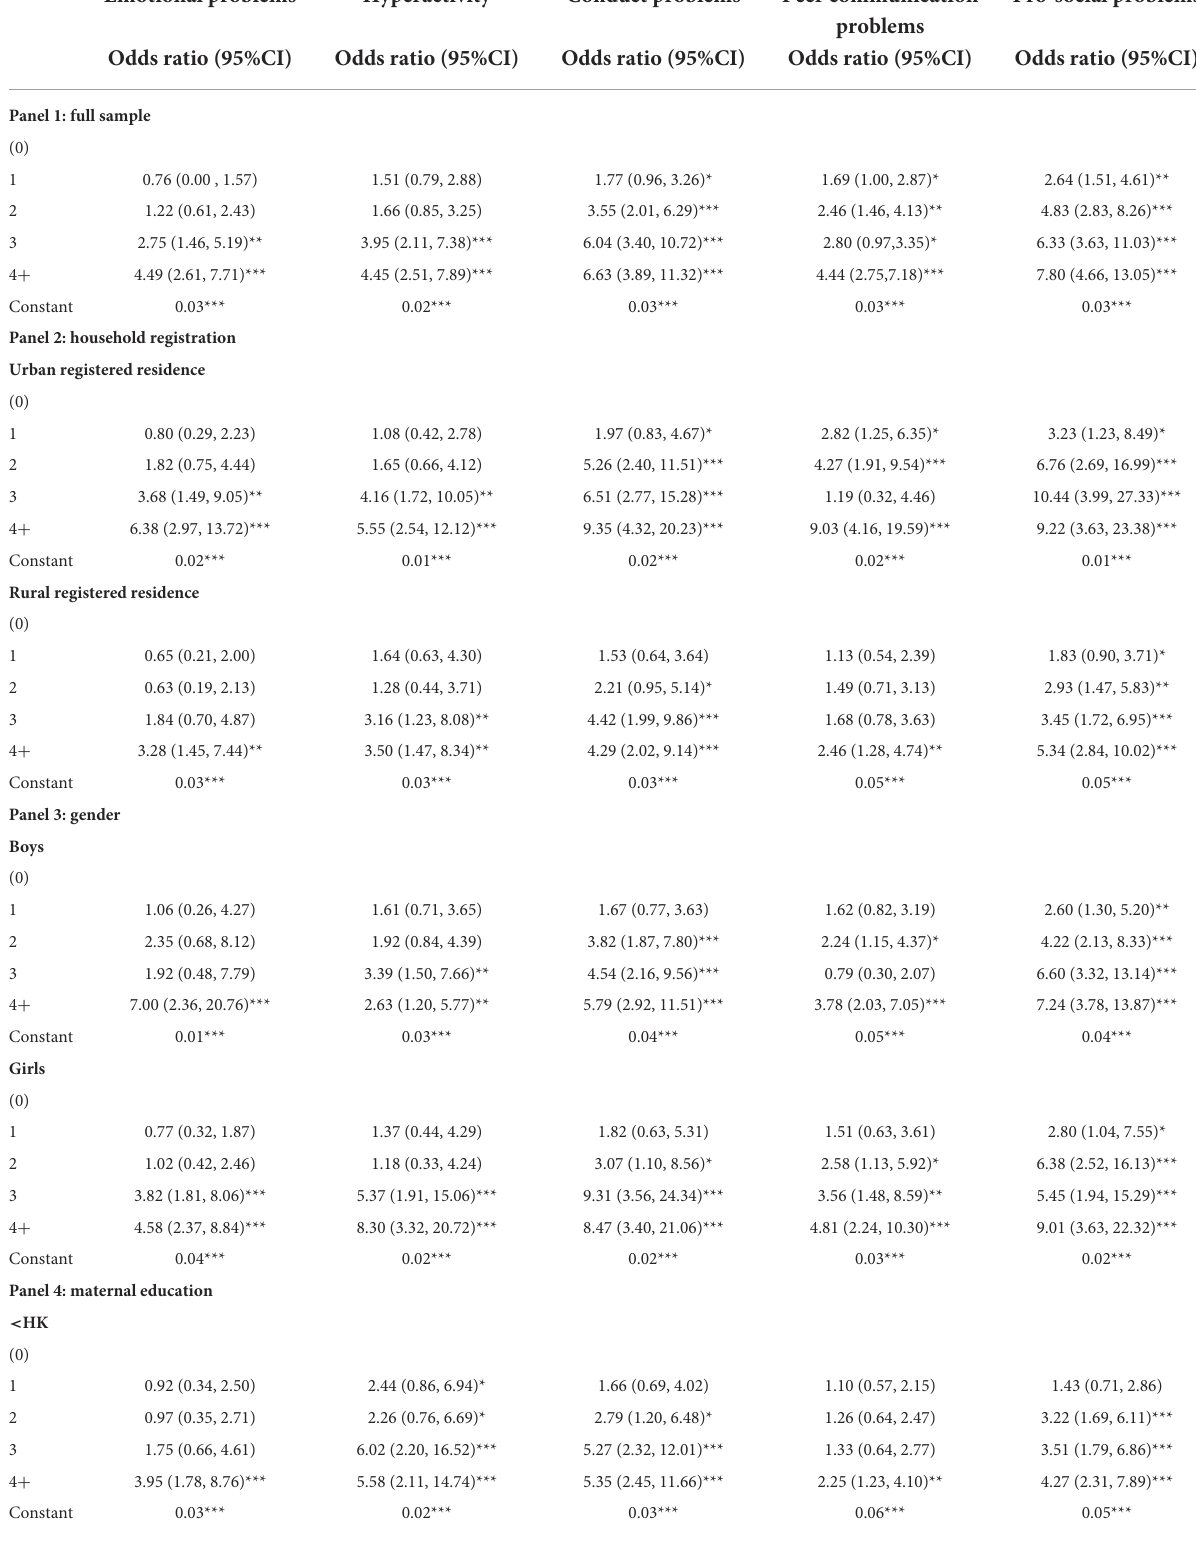
TABLE 2 Logistic regression models estimating the association of ACEs on behavioral problems from 12 to 14 years old. Emotional problems Hyperactivity Conduct problems Peer communication